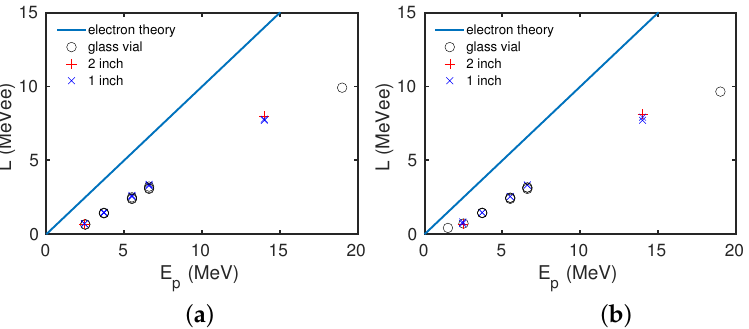
Figure 3. Light output function for all measurements detected using ( a ) PYR5/DIPN scintillator, ( b ) THIO5/DIPN scintillator.